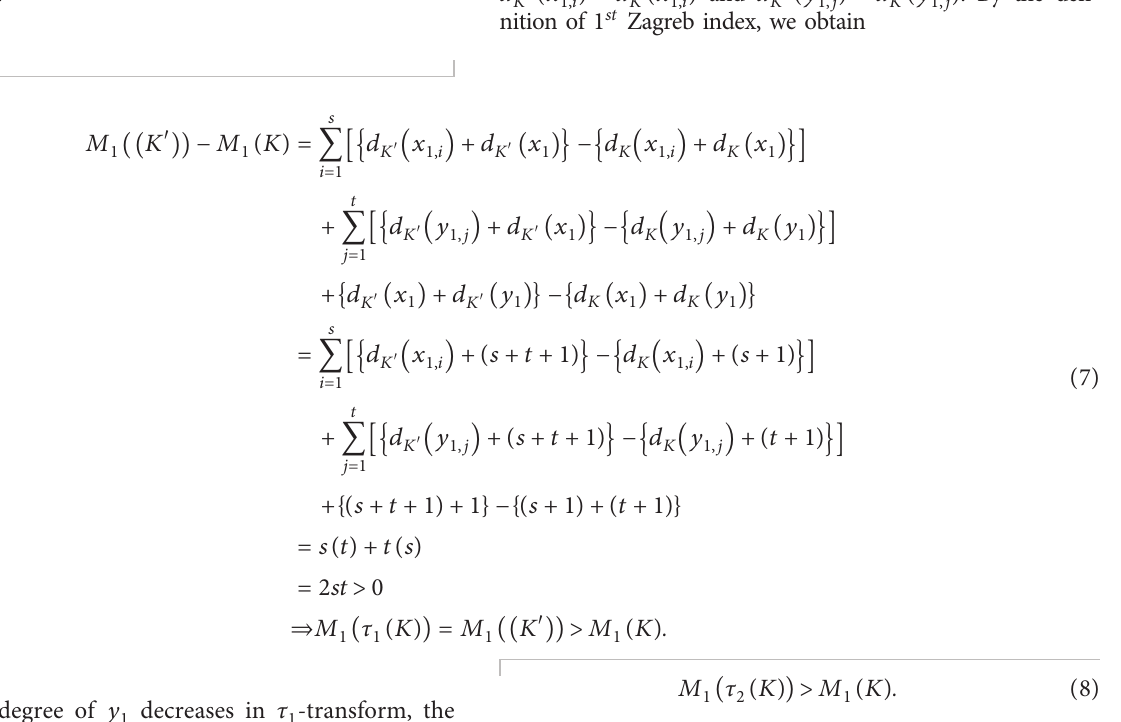
Figure 1: τ -transform applied to K 1